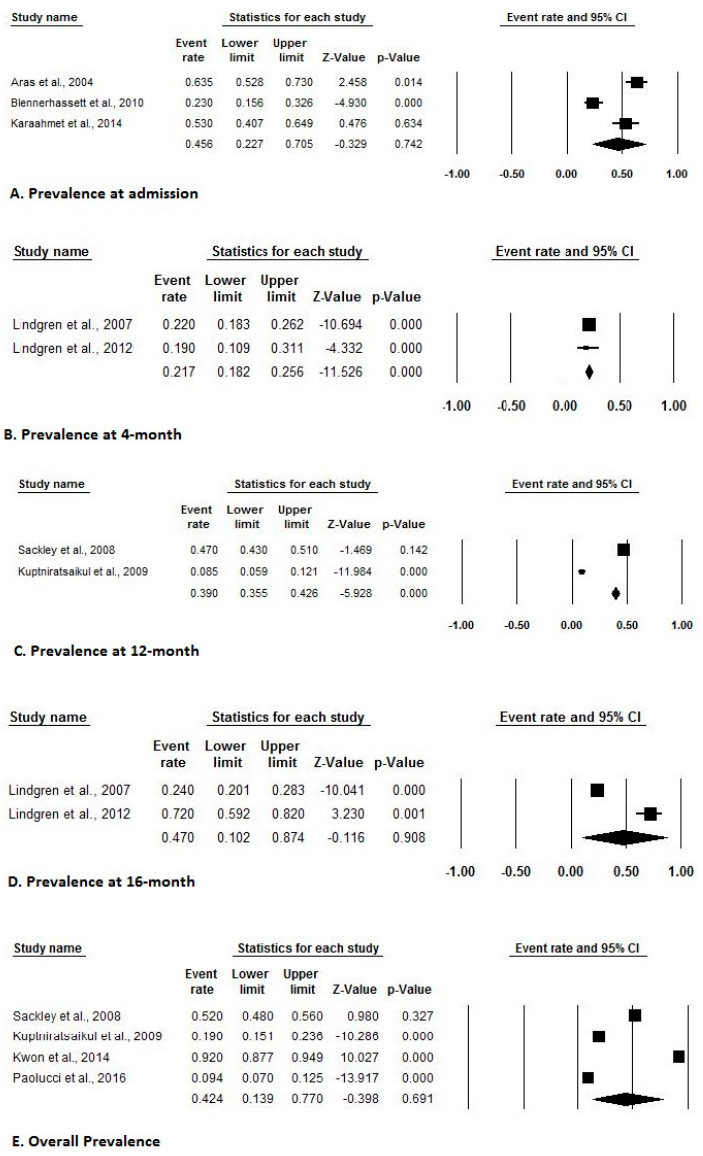
Figure 2. Prevalence of shoulder pain after stroke (( A ). Prevalence at admission, ( B ). Prevalence at 4-month, ( C ). Prevalence at 12-month, ( D ). Prevalence at 16-month, ( E ). Overall prevalence).